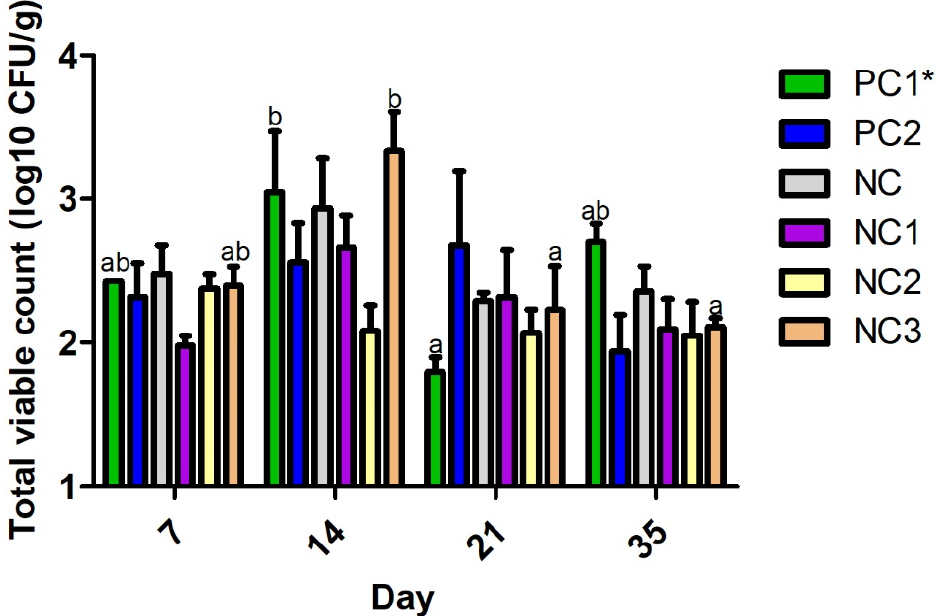
Figure 1. The effect of the plant materials on the bacterial load of Campylobacter spp. in the caecum from 7 to 35 days of age. Means without common superscripts ( ab ) indicate the significant differences (*, p < 0.05)between the treatments. PC1 = positive control 1 (NC+40mg/kg amoxicillin); PC2 = positive control 2 (recommended nutrient specification); NC = negative control (reduced nutrient specification); NC1 = NC + herb of A. pilosa Ledeb; NC2 = NC + herb of A. chinensis Bunge; and NC3 = NC + tuber of S. glabra Roxb.